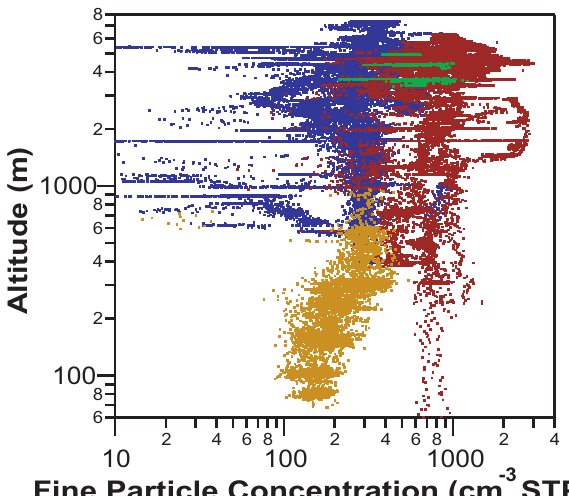
Fig. 3. Vertical profiles of CCN concentrations measured during ARCPAC. Data shown are 1 Hz measurements and are color-coded by air mass type as in Figures 1 and 2.